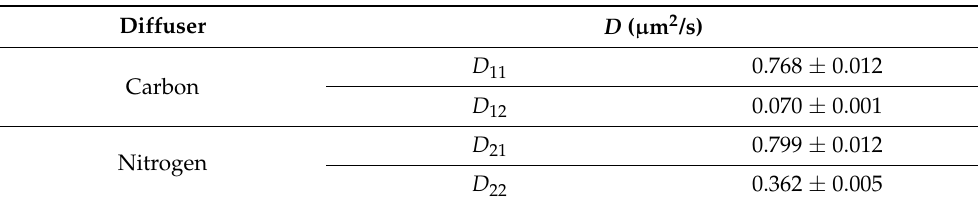
Table 3. Diffusion coefficients of carbon and nitrogen, taking into account the interaction of flows of diffusing